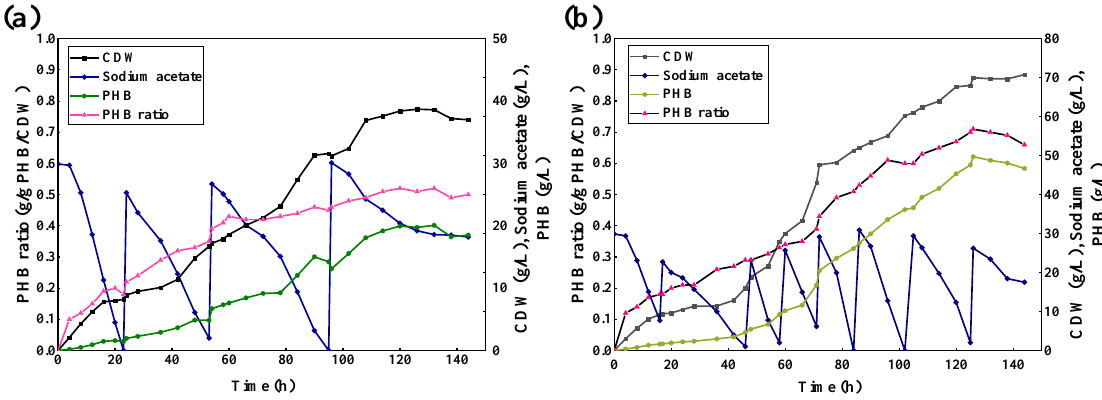
Figure 5. Fed-batch fermentation of ( a ) TD1.0 and ( b ) B71 with acetate as the carbon source in 5 L bioreactor. Table 2. Comparison of PHA production of several microorganisms using acetate as carbon source.